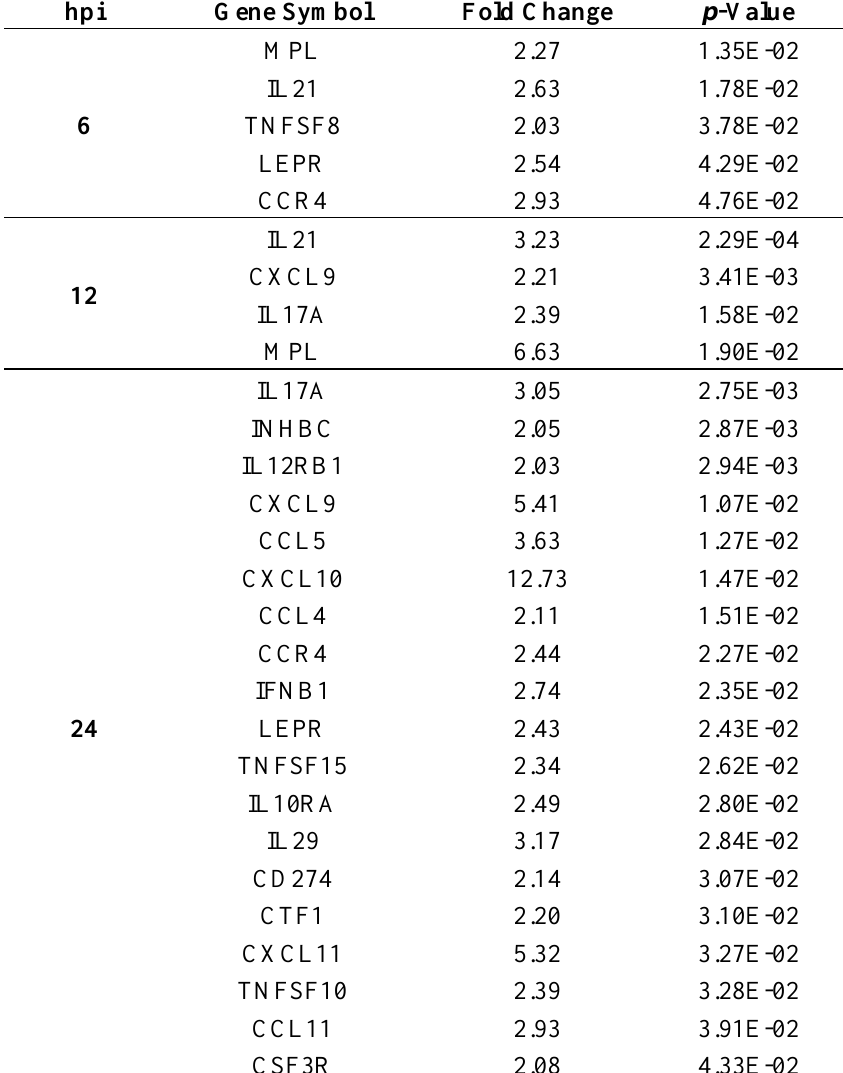
Table 2. Differentially expressed genes associated with pro-inflammatory